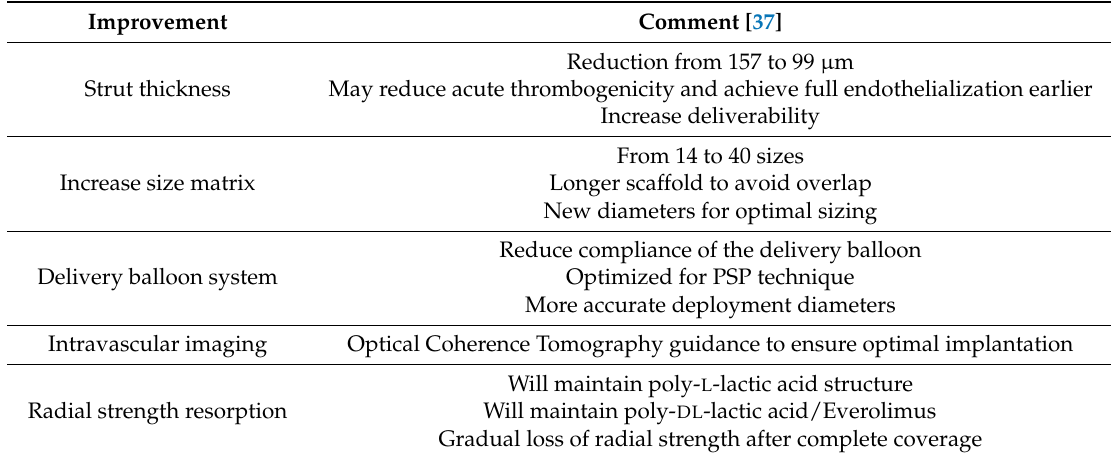
Table 3. Falcon Bioresorbable Scaffolds Design and Development